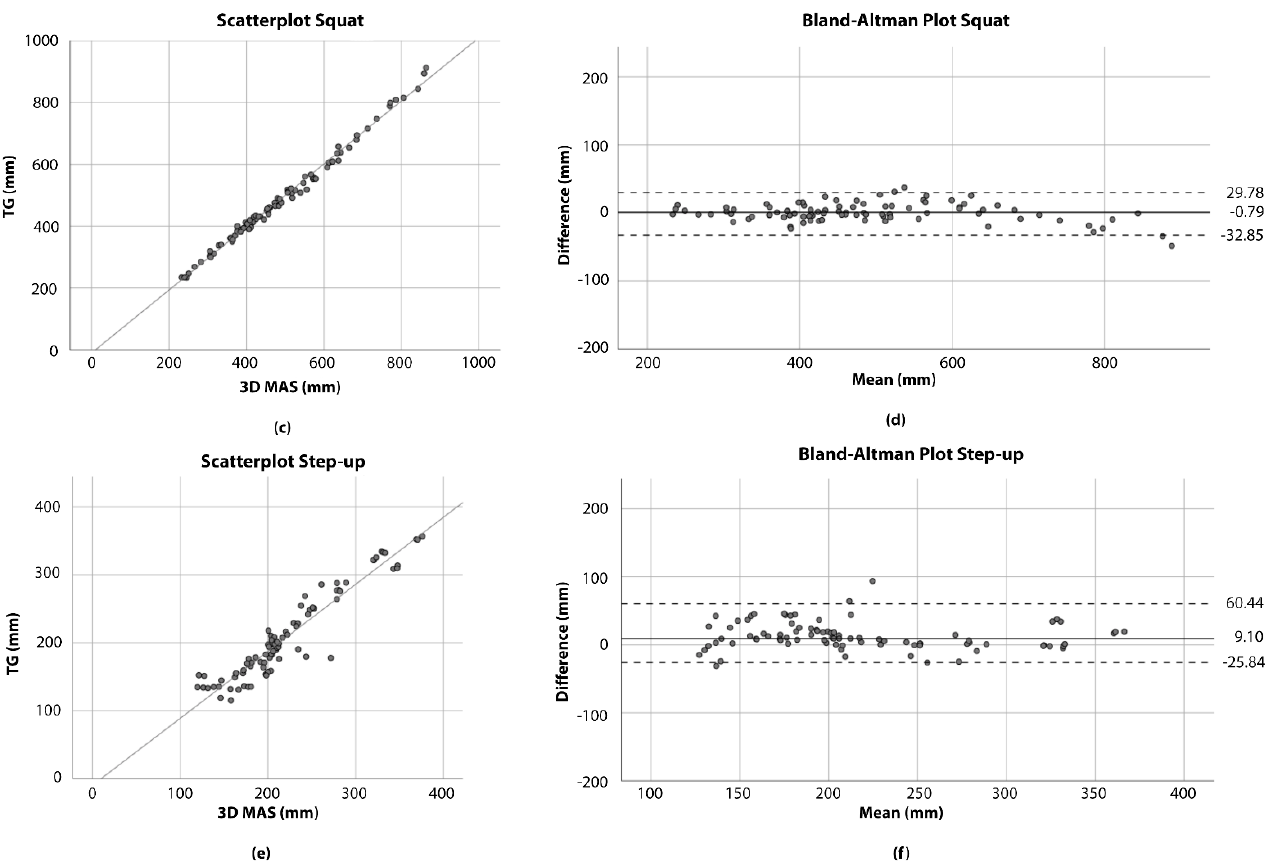
Figure 5. Scatterplots and Bland-Altman plots for the examined exercises. In the Bland-Altman plots the dotted lines represent the limits of agreement and the bold line the median. ( a ) Shows the scatter plot for the side-step. ( b ) Shows the Bland-Altman plots for the side-step. ( c ) Shows the scatter plot for the squat. ( d ) Shows the Bland-Altman plots for the squat. ( e ) Shows the scatter plot for the step-up. ( f ) Shows the Bland-Altman plots for the step-up.